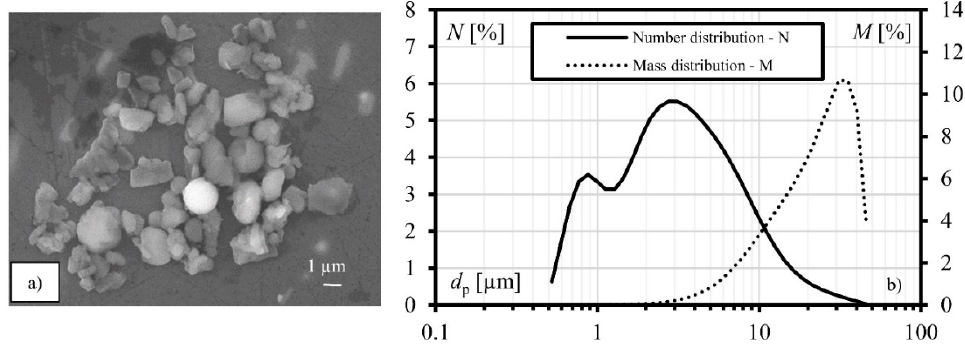
Figure 2. Characteristics of the powder employed: ( a ) SEM observation, and ( b ) number and mass distribution. mass